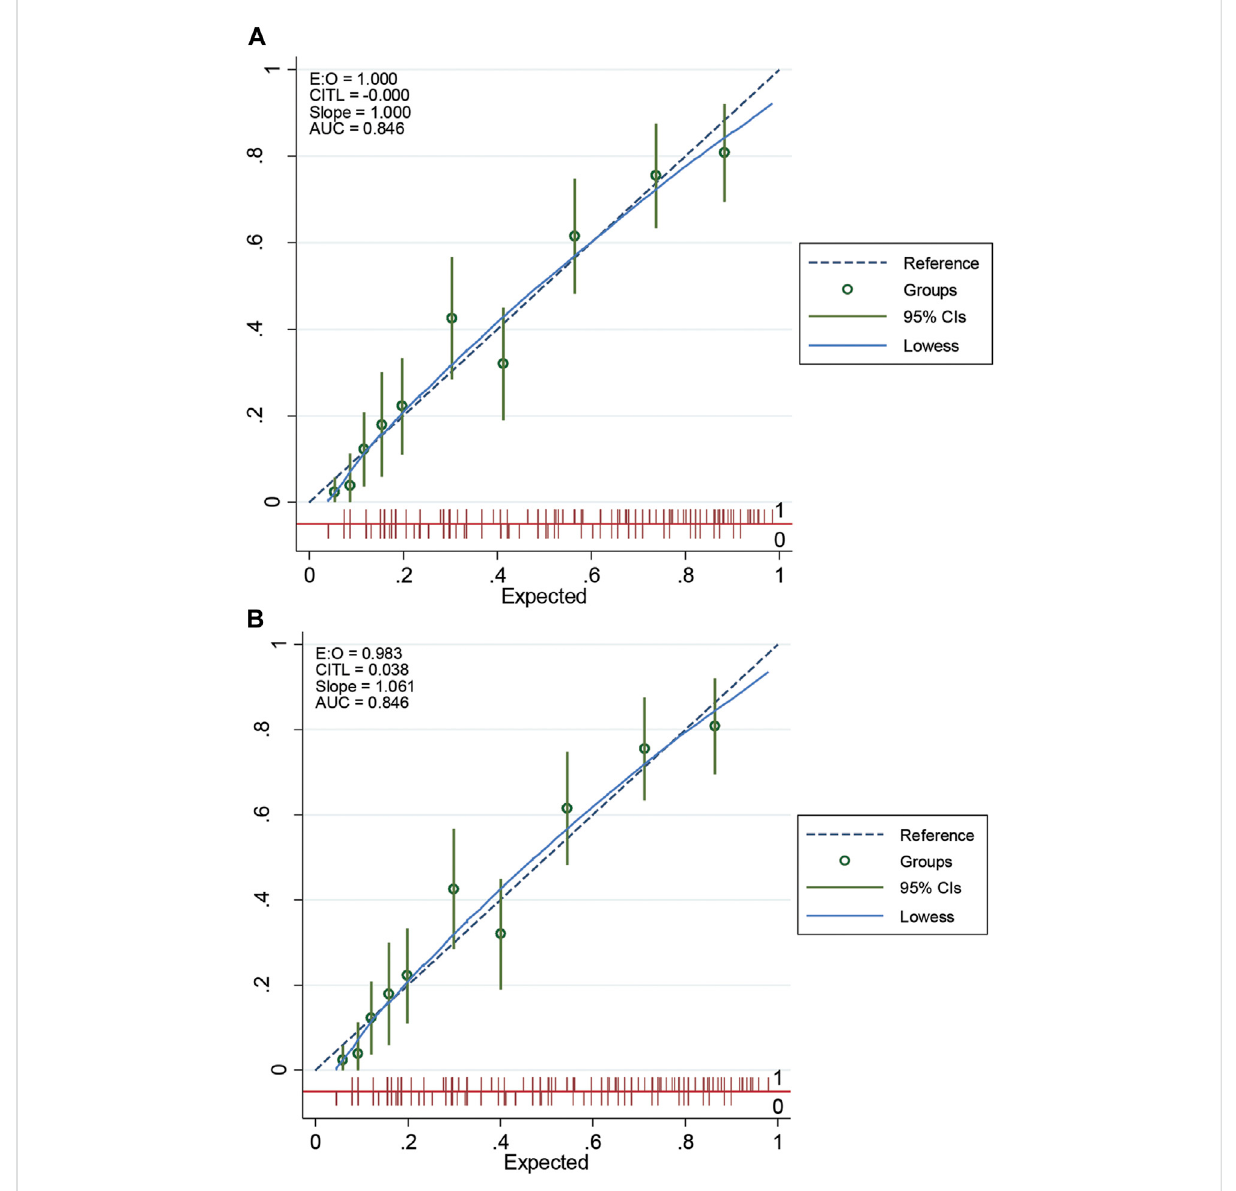
FIGURE 4 The calibration curveoforiginal performance expressed in (A) ;Internally validatedperformance expressedin (B) .EO: expected-observedratio; CITL: calibration-in-the-large; AUC: area under the receiver operating characteristic curve; CI: con fi dence